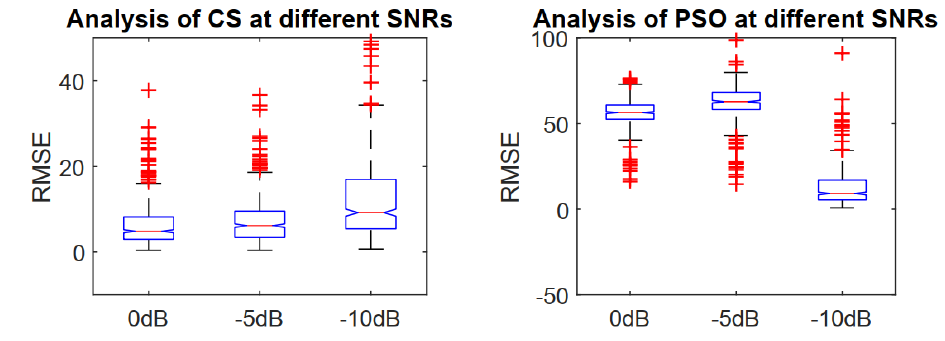
Figure 12. Variation analysis of CS and PSO by estimating twelve